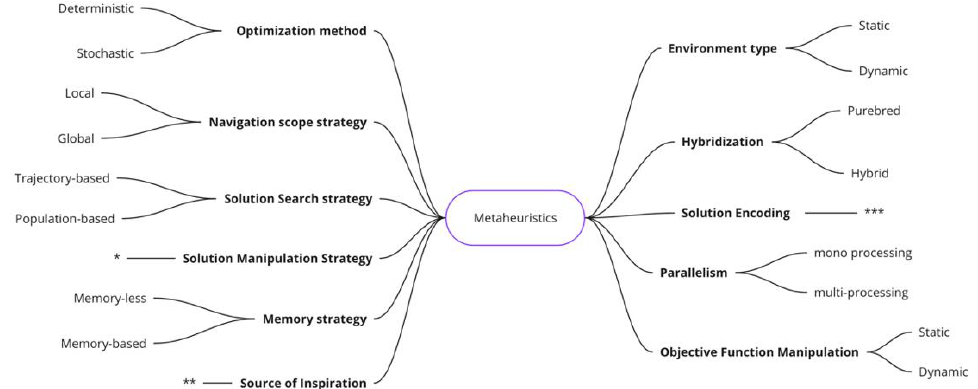
Figure 3. The most common dimensions of metaheuristics classifications found in the literature. * The Solution Manipulation Strategy requires a deeper explanation of how the metaheuristics can be subdivided. ** The source of inspiration has several different views in the literature. *** The same division found in the COP system of classification.